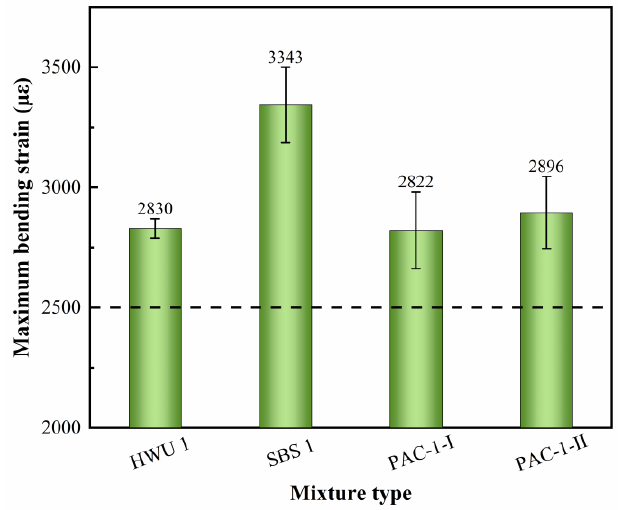
Figure 8. Bending beam test results of the mixtures.